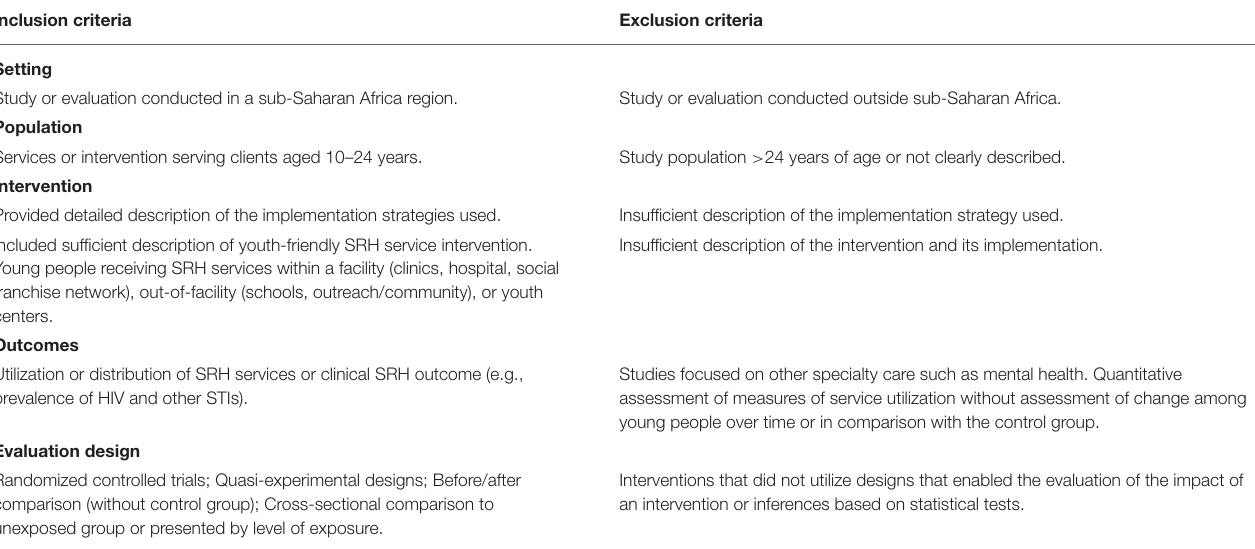
TABLE 2 | Inclusion and exclusion